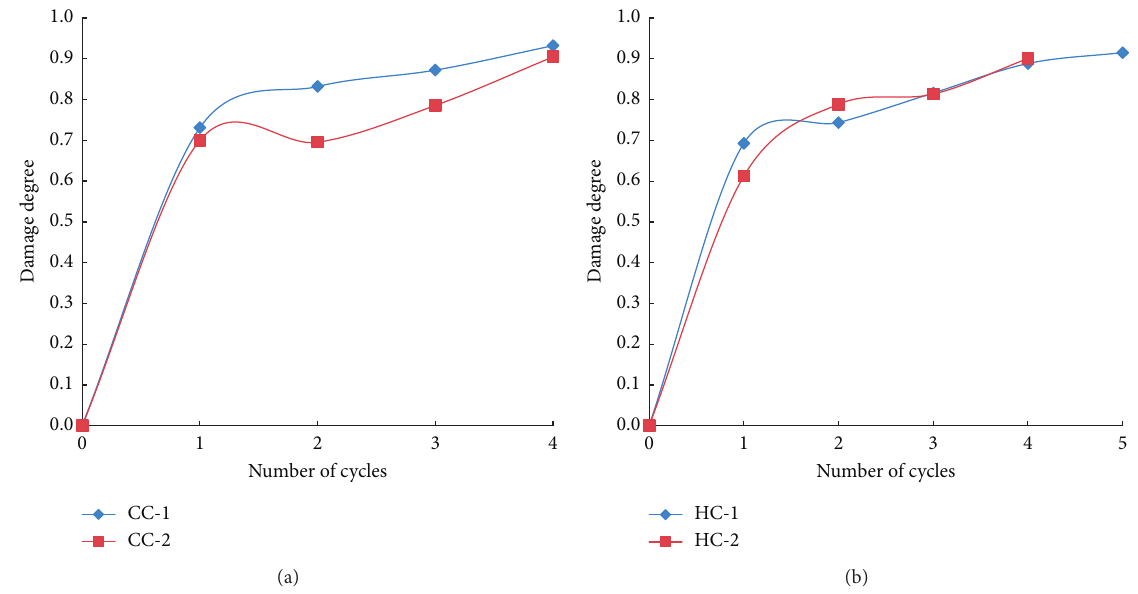
Figure 8: Relation between damage degree and number of impact cycles t . (a) Mortar. (b)